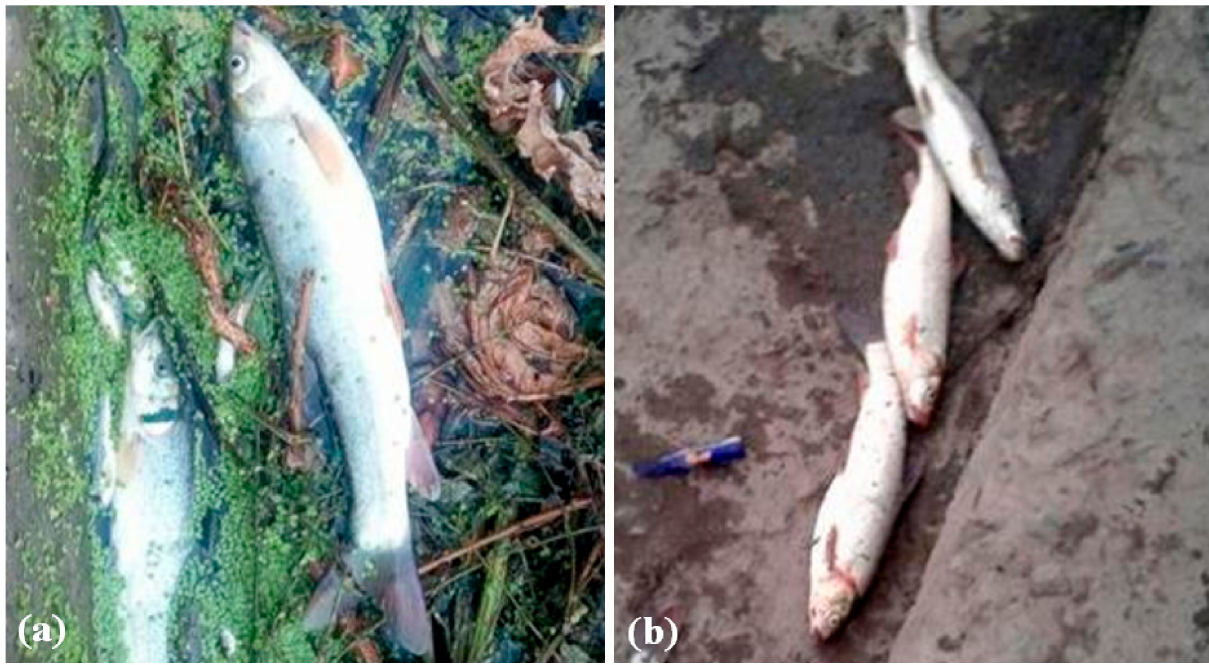
Figure 2. Morphological changes in Shizothorax curvifrons : ( a ) bulged-out eyes, black and white spots, ( b ) pigment discoloration, abnormal